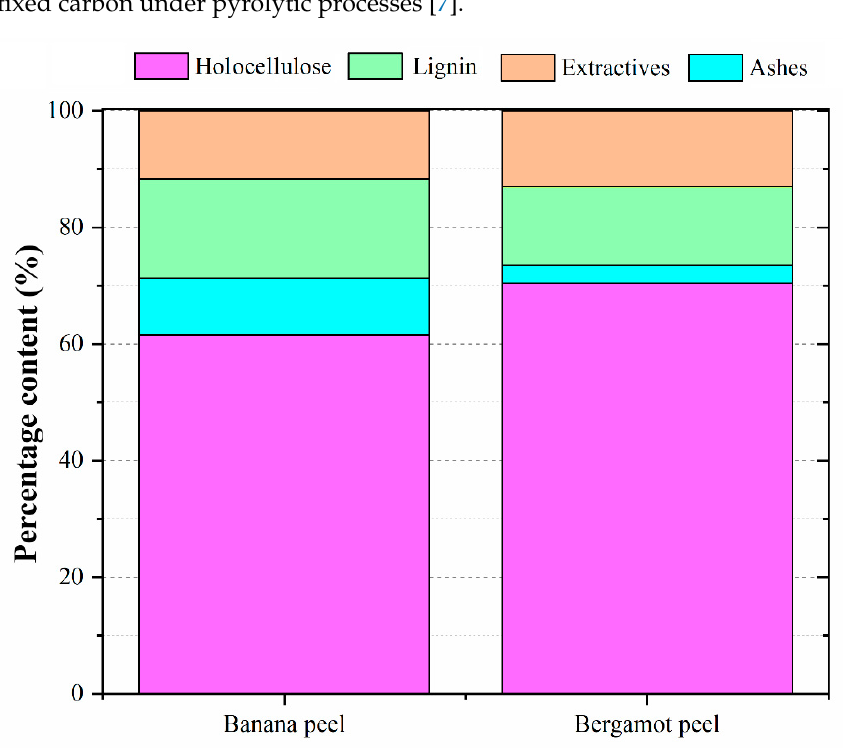
Figure 2. Chemical properties of the banana and bergamot peels.